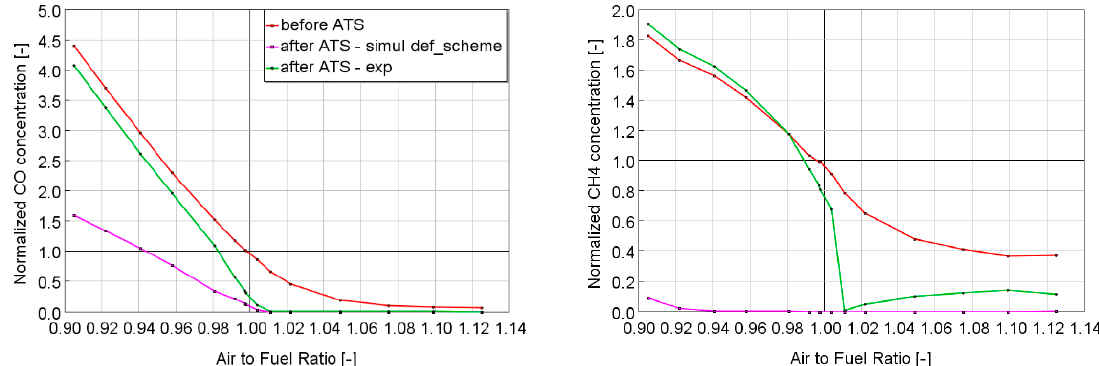
Figure 5. CO and CH 4 conversions with the uncalibrated (GT-Suite default) kinetic scheme from [17]. Gas Temp. ≈ 760 ◦ C. (1900 RPM, 100% load). Oxygen Storage